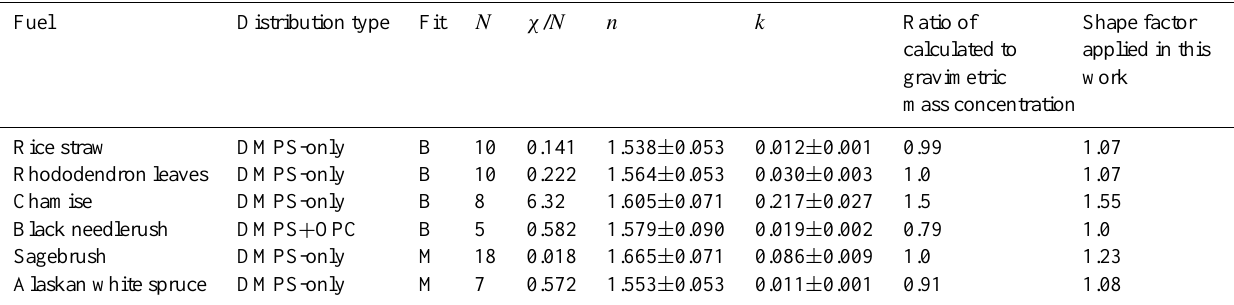
Fig. 1. Examples of measured aerosol size distributions (solid black lines) for six selected experiments. The dashed black lines indicate the lognormal fit size distributions. The dashed red lines indicate the lognormal fits for size distributions after adjusting by the shape factors shown in Table 2. Table 2. Retrieved complex refractive indices ( n and k ) and ω meas for selected burns, using lognormal distribution fits to the aligned volume size distributions after shifting by the appropriate shape factor. The fit lognormal distribution is indicated as monomodal (M) or bimodal (B); N is the number of samples for which the fit was minimized; and χ /N the merit function for that experiment. The eighth column indicates an estimate of the shape factor obtained by comparing total mass concentrations derived from gravimetric filter measurements with those calculated from size distributions and estimated densities (see text). The final column indicates the shape factor applied to derive the complex refractive indices in columns 6 and 7, and also used in construction of Fig.